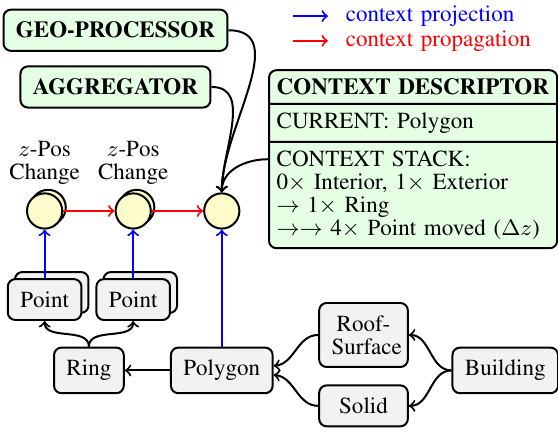
Figure 4. The three components Context Descriptor, Geo-processor and Aggregator for context